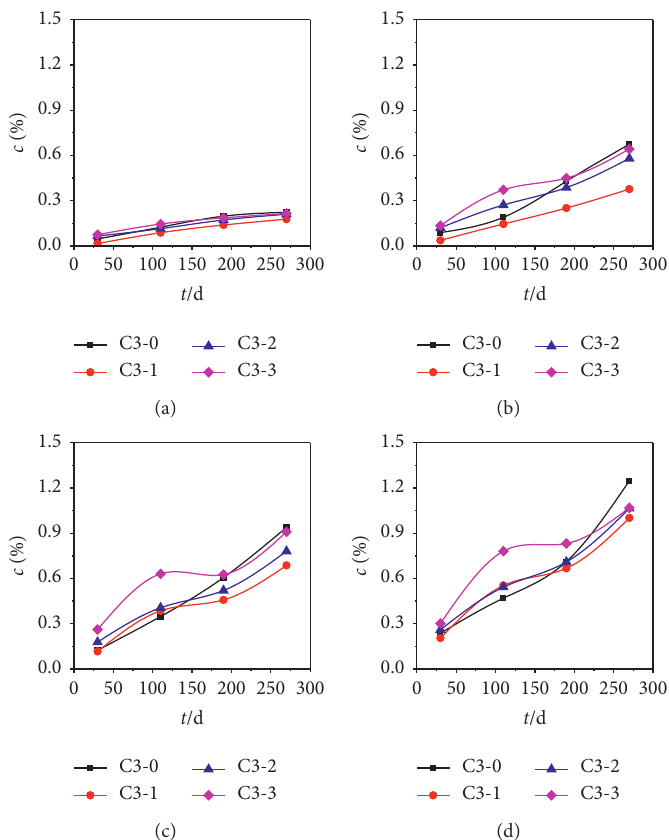
Figure 10: Variation of CIC with corrosion time for fly ash concrete after 0 (a), 30 (b), 60 (c), and 90 (d) freezing-thawing cycles.